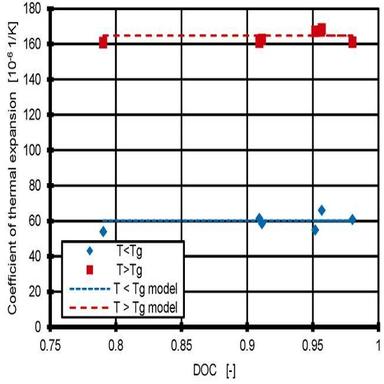
Variation of the LCTE with DOC according to eq. before and after the glass transition based on TMA measurements.